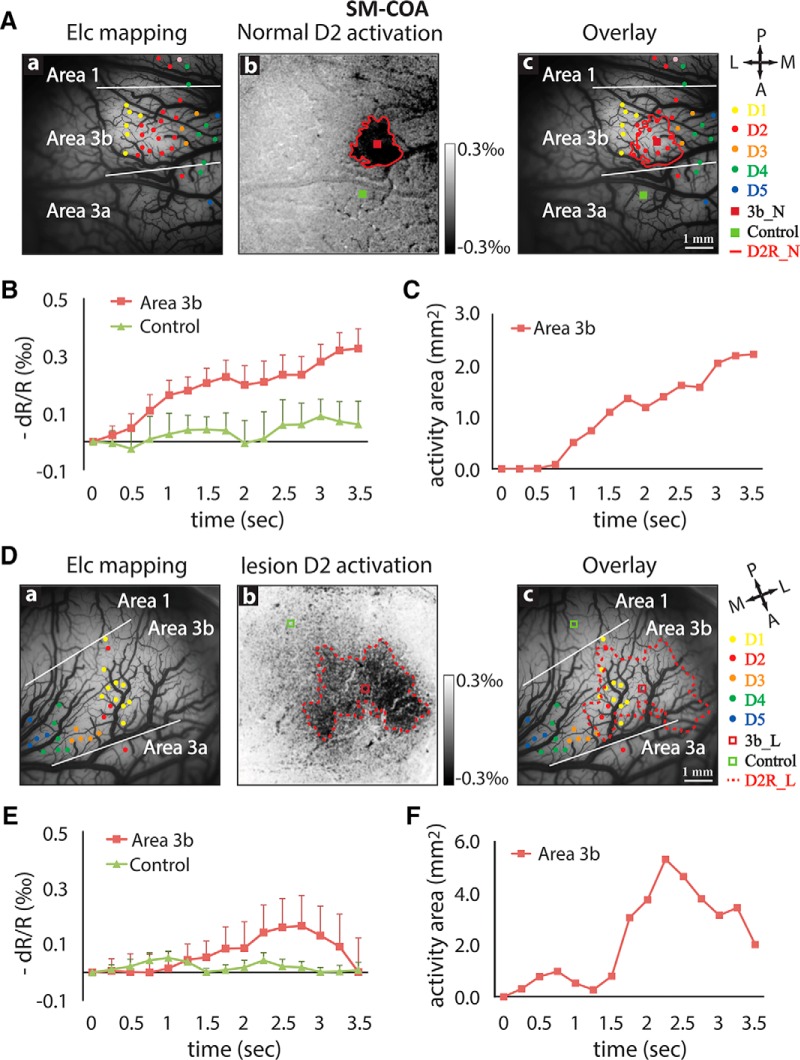
Spatiotemporal dynamics of optical imaging activation to single-digit (D2) stimulation in normal and lesioned somatosensory area 3b in a third monkey (SM-COA). A, Normal cortex. Aa–Ac, Electrophysiological map of digit representation (Aa), D2 activation map (blue outline) of the vibrotactile stimuli in contralateral normal cortex (Ab), and the overlay (Ac). B, Time courses of the optical imaging signals of D2 activation in area 3b (blue outline) and one control location (red outline). C, Temporal profile of the size changes of D2 area 3b activation. D, Deafferented cortex. Electrophysiology digit representation map (Da), average D2 activation map (Db), and overlap map (Dc) at 8 weeks postlesion. E, Time courses of the optical signals of D2 activation in area 3b (blue outline) and in one control region (red outline). F, Change of D2 activation size in area 3b during stimulation ipsilateral to the side of the spinal cord injury. Error bars indicate the SE.